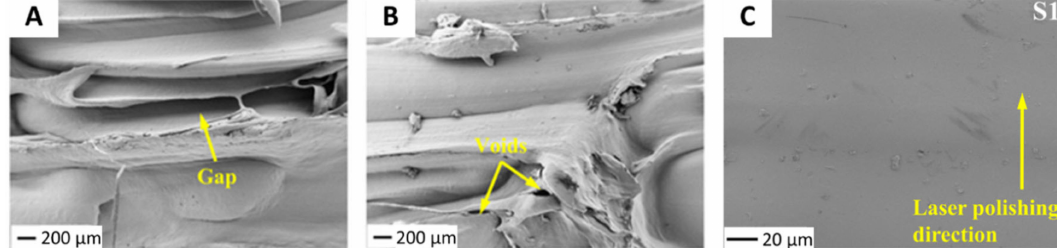
Figure 5. Poly(lactic acid) (PLA) / copper fiber surfaces ( A , B ) before laser treatment showing gaps, voids, and uneven surface morphology and ( C ) after 5 W laser treatment with a 175 µ m beam. Reproduced with permission from [49], Wiley,